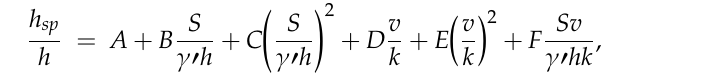
Table 4. Optimal value of constant coefficients for h sp /h.